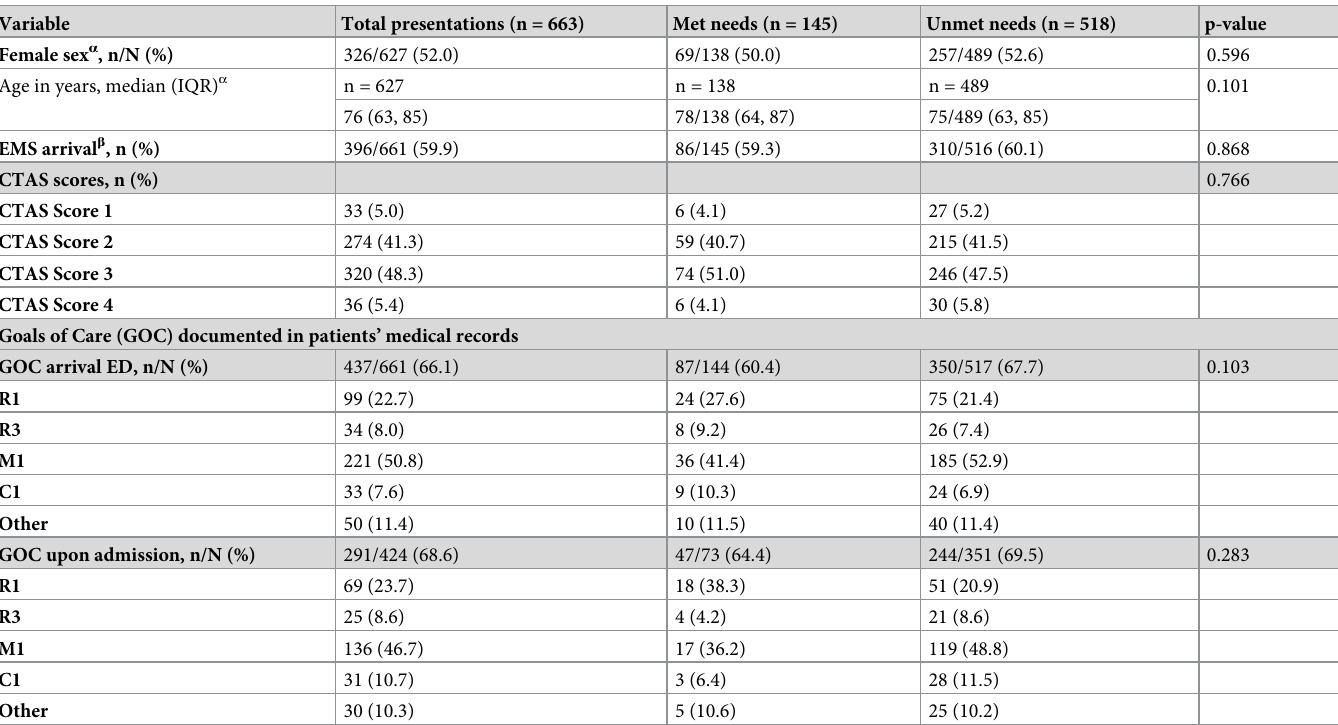
Table 1. Characteristics and goals of care documentation in a study of 663 presentations to the emergency department by patients with end-of-life conditions, sub- grouped by met and unmet palliative care